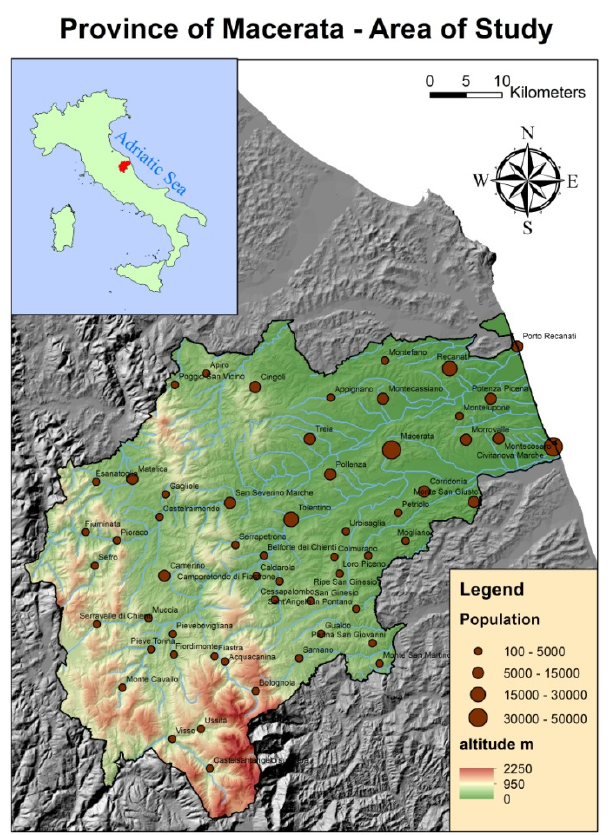
Figure 1. Geography of the province of Macerata [23].